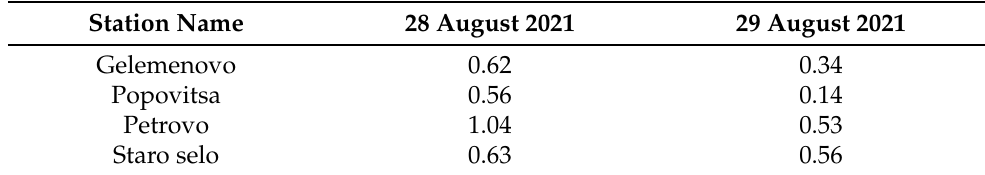
Table 2. IWV hourly increase between 6 and 16 UTC on 28 (second column) and 29 August (third column).